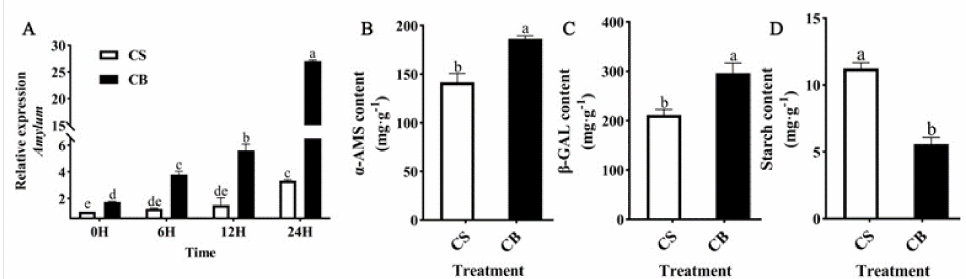
Figure 3. Effects of betaine pretreatment on the expression levels of key genes for starch synthesis in tomato seeds on the seventh day of low-temperature stress: ( A ) amylase related gene expression level, ( B ) α -AMS content, ( C ) β -galactosidase content, ( D ) total starch content in tomato seeds on the seventh day of low-temperature stress. Different lowercase letters indicate significant differences at the 0.05 probability level ( p < 0.05). CS: germination of seeds pretreated with just water under